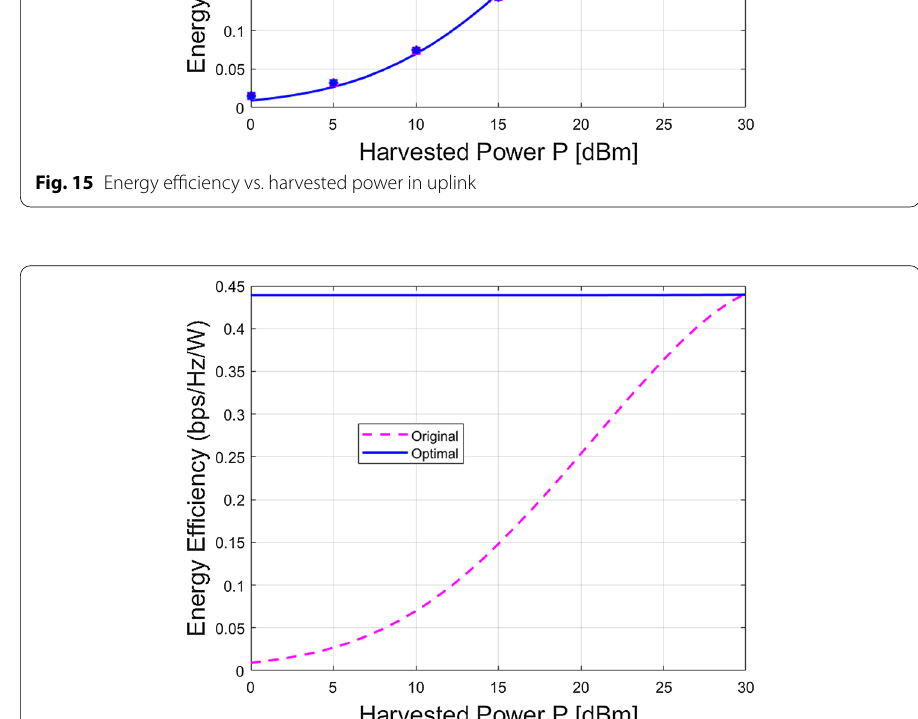
Fig. 16 Energy efficiency vs. harvested power comparison in